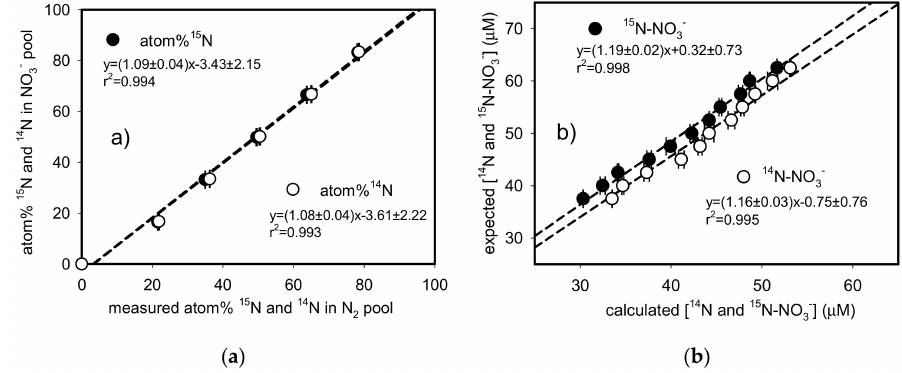
Figure 5. 15 N atom% in the pool of N 2 produced by denitrification of di ff erent standard solutions containing mixtures of 14 N-NO 3 − and 15 N-NO 3 − versus 15 N atom% of the nitrate in the standards ( a ). Calculated versus added 14 N-NO 3 − and 15 N-NO 3 − concentrations in standard solutions containing mixtures of 14 N-NO 3 − and 15 N-NO 3 − ( b ). Details on concentrations of the two isotopes, incubation time, and slurry concentrations are reported in Table 1. Each slurry was run in triplicate; averages and standard errors are